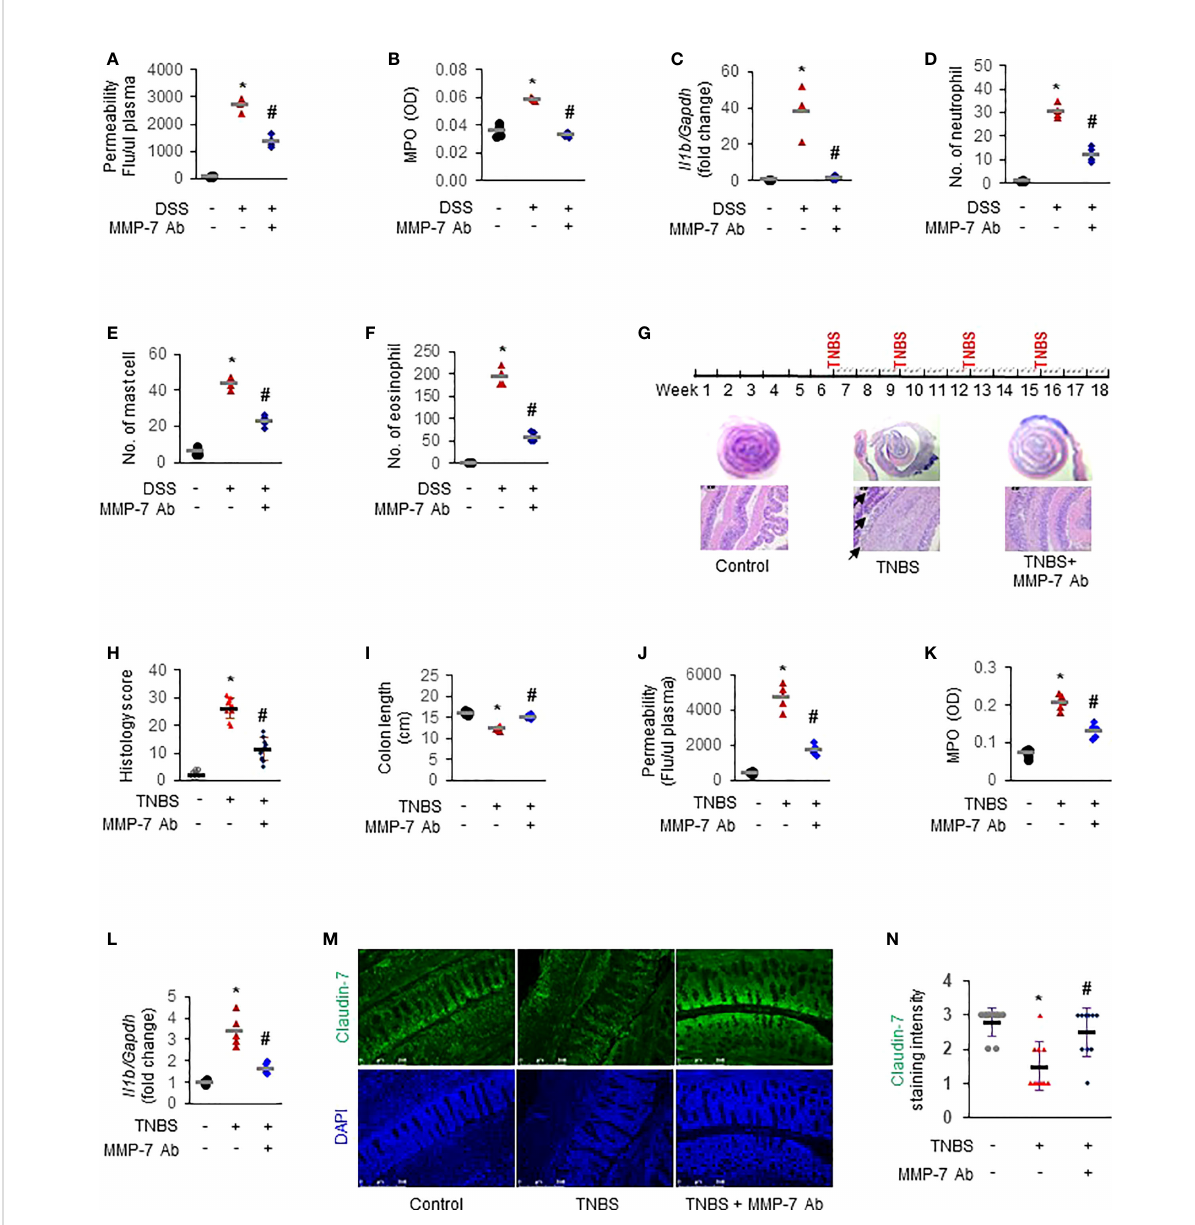
FIGURE 7 MMP-7 neutralizing antibody mitigates colonic in fl ammation in rodent models of colitis. For acute model mimicking ulcerative colitis, C57BL/6 mice were given 3% DSS in drinking water for 7 days. MMP-7 neutralizing antibody was administered once daily by i.p. injection. For chronic model mimicking Crohn ’ s disease, Sprague Dawley rats were treated with intrarectal injection of TNBS (50 mg/kg) 4 times, with intermittent 3- week intervals. MMP-7 neutralizing antibody was i.p. administered on Mondays, Wednesday, and Fridays for a total of 12 weeks. Animals in the control groups received regular drinking water (for acute model) or saline (for chronic model) as well as i.p. injection of respective IgG in saline. Colon tissue was fi xed or snap-frozen after permeability assays. In fl ammatory cells were evaluated by two independent pathologists. (A) In vivo colonic permeability of DSS mice measured with FITC-dextran at day 7. (B) MPO activities in the DSS mouse colon tissue. (C) RT-qPCR analysis of interleukin 1 b ( Il1b ) mRNA levels in the DSS mouse colon tissue. (D) Numbers of neutrophils stained with H&E in the DSS mouse colons. (E) Numbers of mast cells stained with toluidine blue in the DSS mouse colons. (F) Numbers of eosinophils stained with H&E in the DSS mouse colons. n=4. * p <0.01 vs control (Ctl) group. # p <0.01 vs DSS group. (G) Dosing protocol (top) and H&E staining of the TNBS rat colons (bottom). Black arrow, severely damaged mucosa. (H) Histological colitis score of the rats. (I) Colon lengths of the TNBS rats. (J) In vivo colonic permeability of the TNBS rats. (K) MPO activities in the TNBS rat colons. (L) Il1b mRNA levels in the TNBS rat colons quantitated by RT-qPCR. (M) Immuno fl uorescence staining of Claudin-7 in colon Swiss roll sections. Nuclear counterstain was done with DAPI. (N) Quanti fi cation of Claudin-7 staining intensity, ranging from absent (0) to highest (3). n=5. * p <0.01 vs control (Ctl) group. # p <0.01 vs TNBS